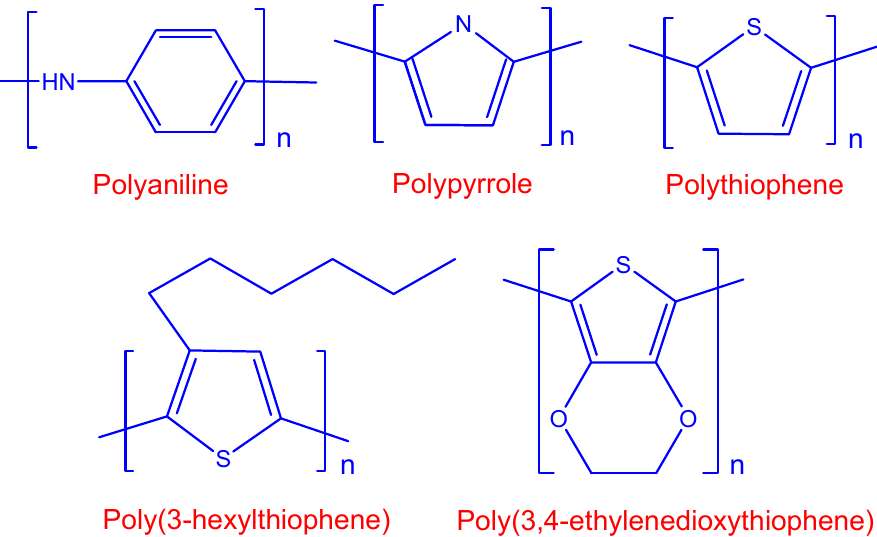
Figure 2. Some important conducting polymers.